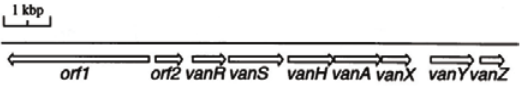
Figure 4: Genetic map of Tn 1546 transposon